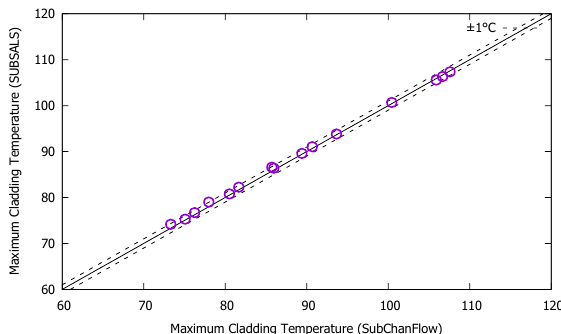
Figure 10. Comparison of maximum cladding tem- perature